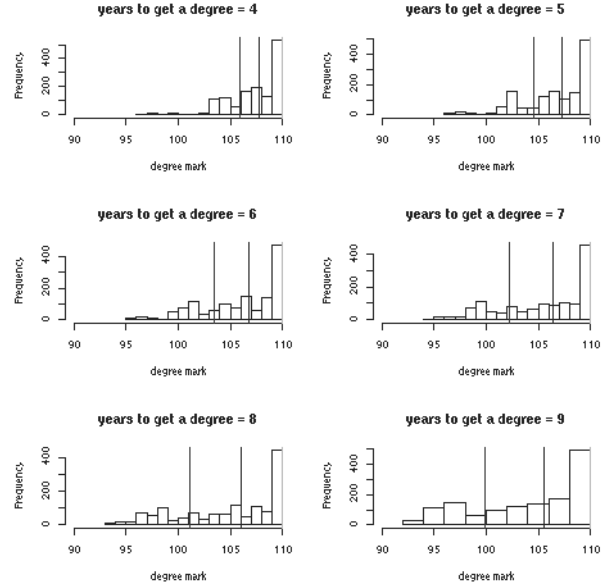
Figure 5 – Histograms of the conditional distribution of the final mark (sex=female, place of resi- dence=Macerata, course attendance=regular, diploma mark=lowest) by number of years to get a